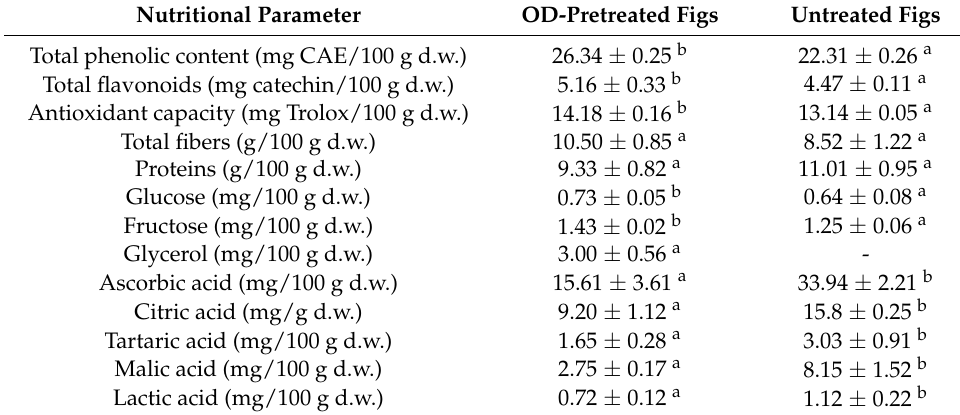
Table 5. Nutritional and bioactive compounds of OD pretreated (45 ◦ C, 90 min, 1/4 ratio of sample per OD solution ( w s / w OD )) and untreated dried figs. Nutritional Parameter OD-Pretreated Figs Untreated